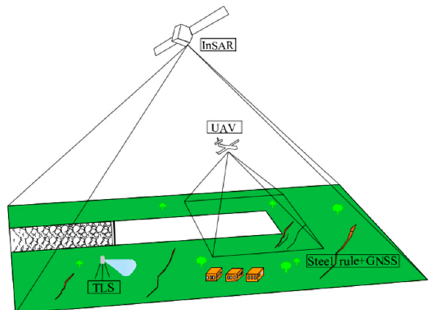
Figure 7. Diagram of the optimized solution for “space-sky-ground” collaborative monitoring at working face 401.